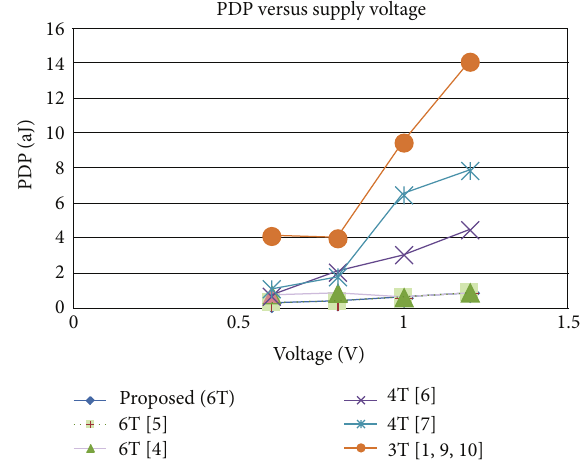
Figure 5: Line graph showing the comparison of the power-delay product (PDP) versus the supply voltage scaling for various XOR gates with the proposed novel CMOS pass-transistor-based full- swing XOR gate.